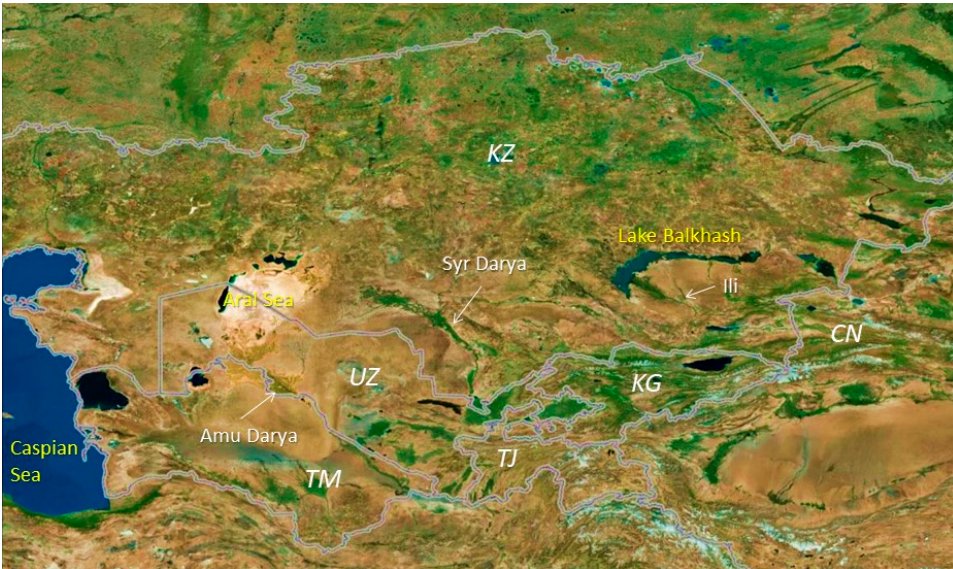
Figure 1. Satellite image of Central Asia identifying the Caspian Sea, remnant Aral Sea, and Lake Balkhash, as well as the Amu Darya, Syr Darya, and Ili rivers. Country abbreviations: CN, China; KG, Kyrgyzstan; KZ, Kazakhstan; TJ, Tajikistan; TM, Turkmenistan; UZ, Uzbekistan.